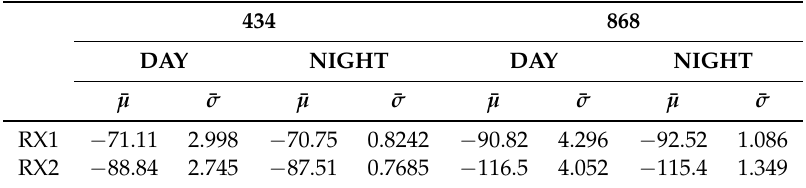
Table 2. Average values of the descriptive statistics describing subsets of indoor power